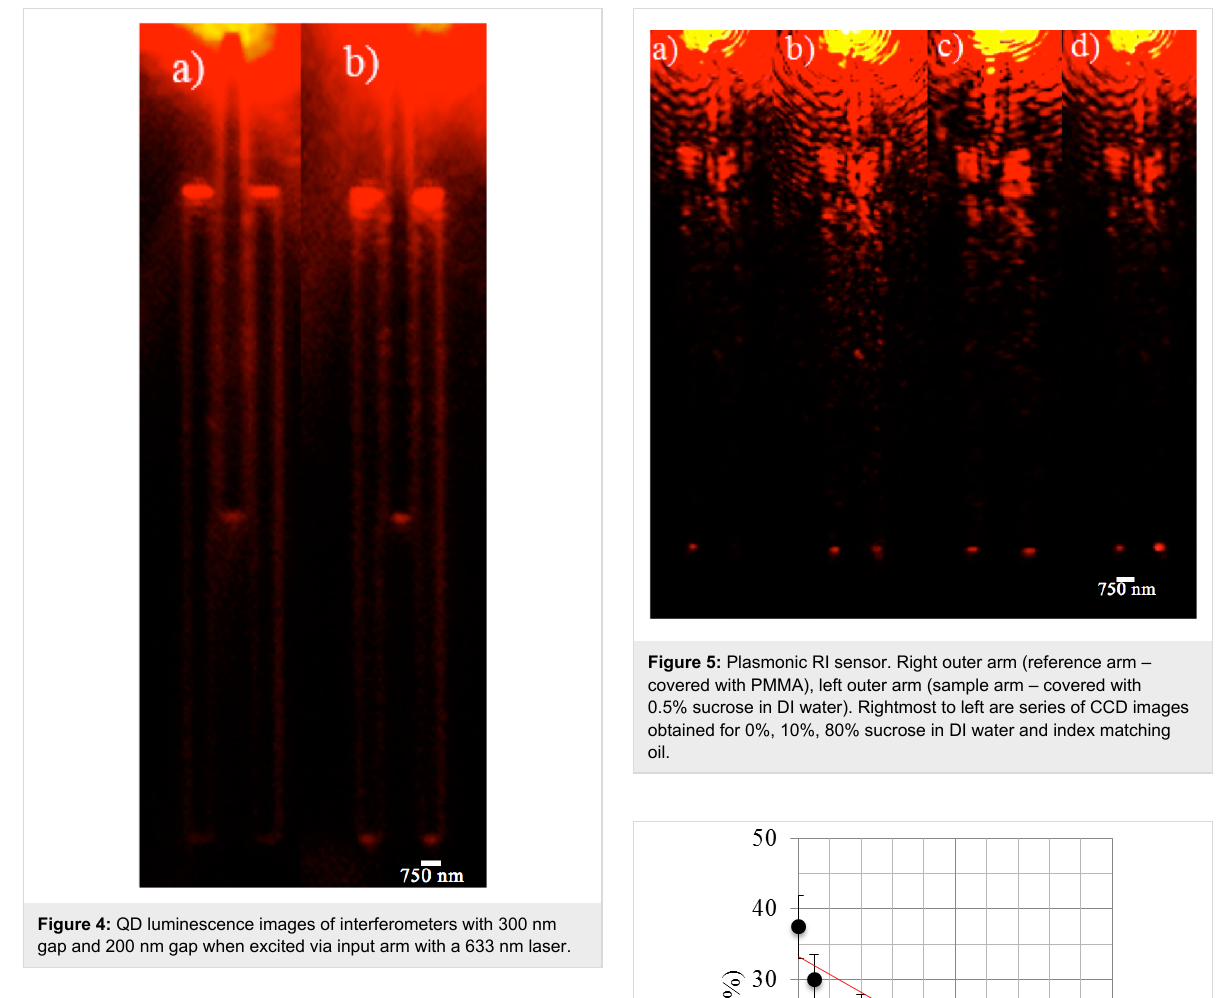
centage in each sucrose solution, where I 0 is the intensity on the reference arm, I r (Equation 3).